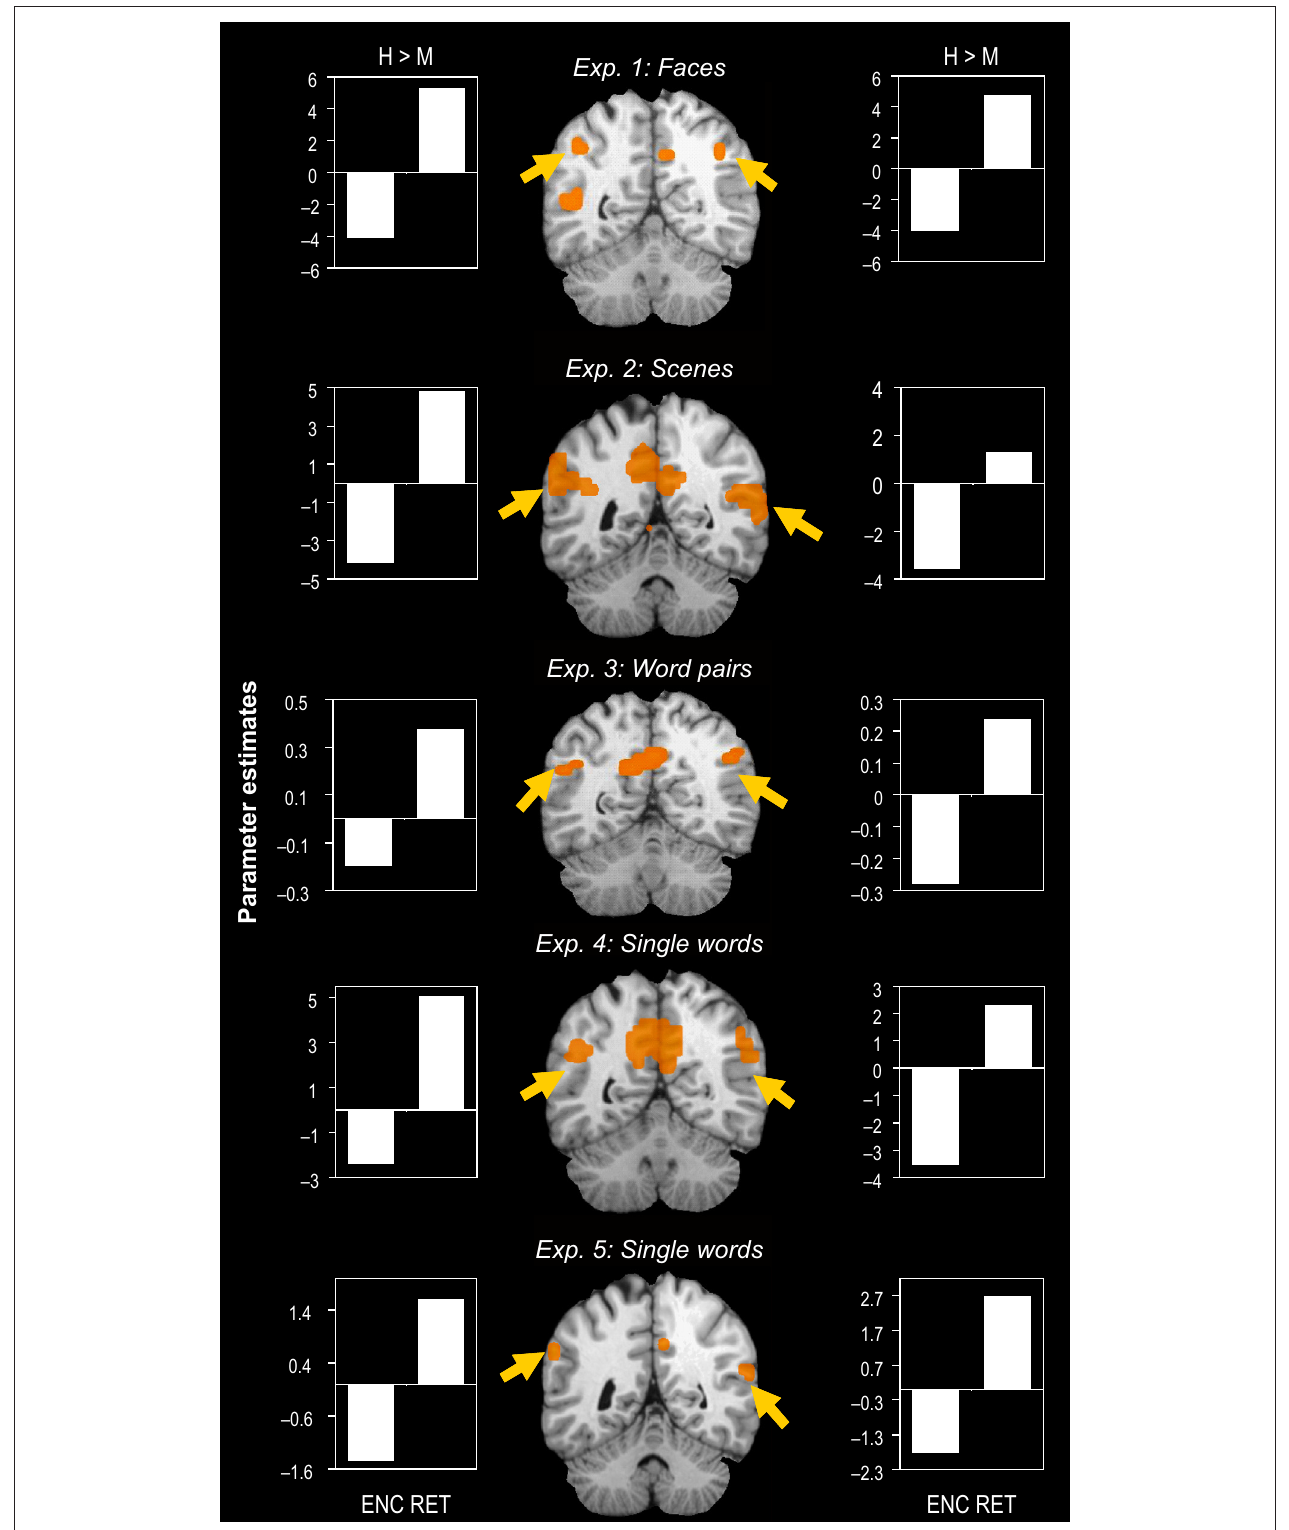
retrieval, activity was greater for hitss than for misses. Bar graphs indicate mean cluster activity for the comparison between hits and misses during encoding and retrieval,